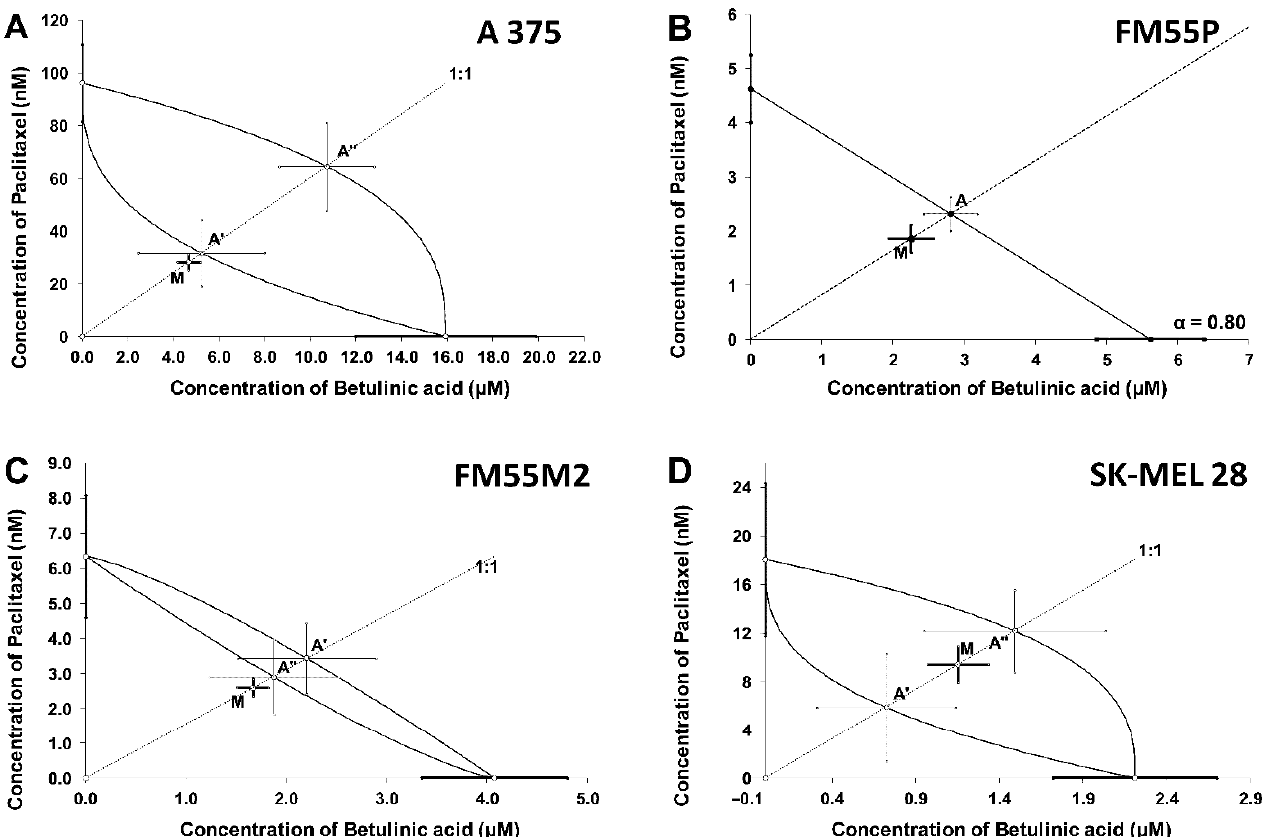
Figure 8. ( A – D ). Isobolograms showing additive interactions between betulinic acid (BA) and paclitaxel with respect to their anti-proliferative effects on A375 ( A ), FM55P ( B ), FM55M2 ( C ), and SK-MEL28 ( D ) malignant melanoma cell lines measured in vitro by the MTT assay. The median inhibitory concentrations (IC 50 ) for BA and paclitaxel are plotted graphically on the X- and Y-axes, respectively. The lower and upper isoboles of additivity represent the curves connecting the IC 50 values for BA and paclitaxel administered alone. The dotted line starting from the point (0. 0) corresponds to the fixed ratio of 1:1 for the combination of BA with paclitaxel. The points A, A’ and A” depict the theoretically calculated IC 50 add values for both, lower and upper isoboles of additivity. The point M represents the experimentally derived IC 50 exp value for a total dose of the mixture expressed as proportions of BA and paclitaxel that produced a 50% anti-proliferative effect (50% isobole) in malignant melanoma cell lines measured in vitro by the MTT assay. On the graph, the S.E.M. values are presented as horizontal and vertical error bars for every IC 50 value.